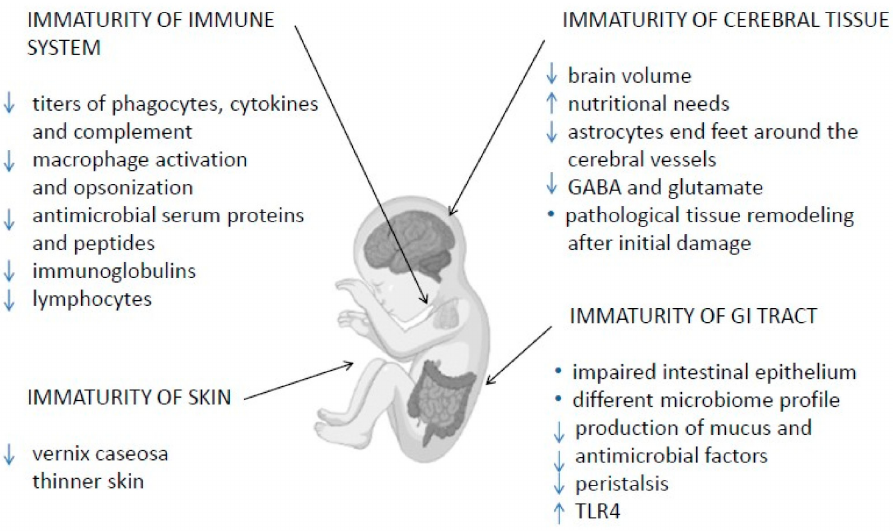
Figure 1. Immaturity of immune, gastrointestinal and nervous systems in very preterm neonates